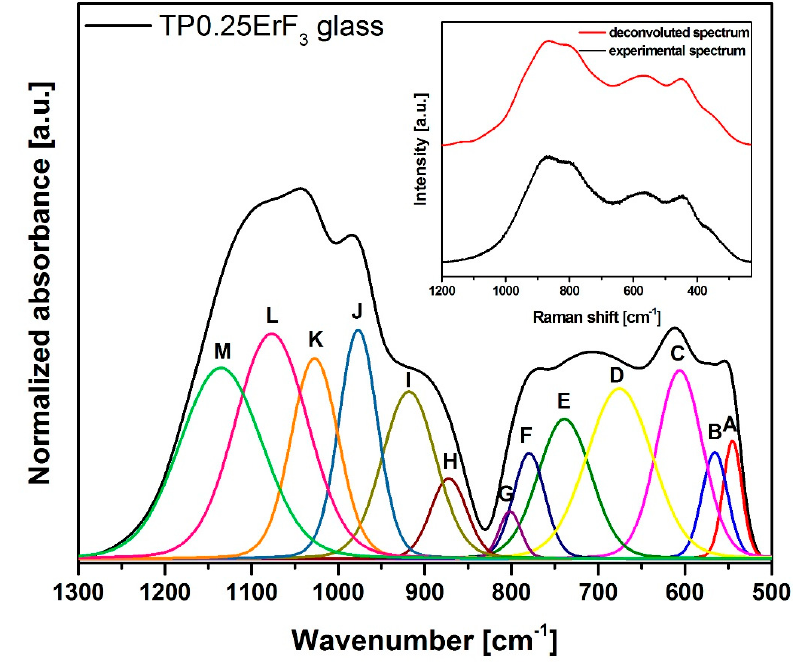
Figure4. DeconvolutedFTIRspectraofTP0.25ErF 3 glass. (inset)Deconvolutedandexperimentalspectra. Figure 4. Deconvoluted FTIR spectra of TP0.25ErF 3 glass. (inset) Deconvoluted and experimental spectra.